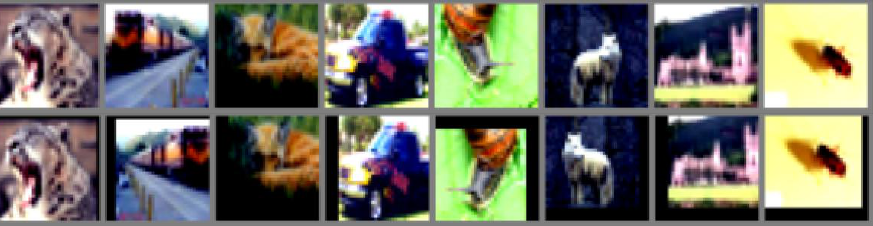
Figure 6. Samples from the CIRFAR-100 dataset. Upper: original image. Lower: augmented image. The labels from left to right: leopard, train, fox, truck, snail, wolf, castle, and cockroach.